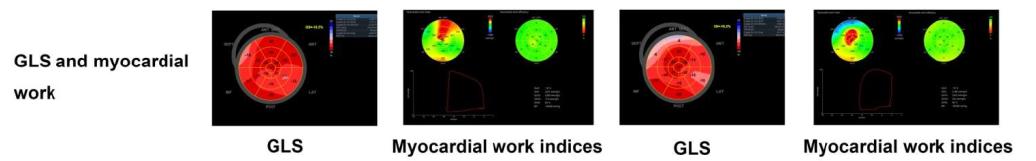
Figure 4. Main echocardiographic findings in primary hypertension and primary aldosteronism. Two representative cases of different echocardiographic parameters in a patient with primary hypertension ( left panels ) and in another with primary aldosteronism ( right panels ) with similar blood pressure. CS—circumferential strain; GLS—global longitudinal strain; LS—longitudinal strain. Values in the figure are expressed as below. Blood pressure: 149/69 in the primary hypertensive patient vs. 150/83 mmHg in the primary aldosteronism patient; left ventricular mass index: 97 vs. 145 g/m 2 , respectively; E/A: 1.4 vs. 0.88, respectively; E/e’: 10.4 vs. 18.9, respectively; CSendo (basal short- axis view): − 42.8 vs. − 39.2%, respectively; CSmid: − 26.3 vs. − 21.5%, respectively; CSepi: − 13.6 vs. − 10.4%, respectively; LSendo (four-chamber view): − 21.4 vs. − 19.9%, respectively; LSmid: − 19.0 vs. − 16.4%, respectively; LSepi: − 16.8 vs. − 13.3%, respectively; LASs (left atrial strain, four- chamber view): 27.8 vs. 20.4%, respectively; LASe: 17.6 vs. 10.7%, respectively; LASa: 10.3 vs. 9.8%, respectively; right ventricular four-chamber longitudinal strain: − 24.6 vs. − 17.3%, respectively; GLS: − 18.5 vs. − 16.2%, respectively; global myocardial work index: 2201 vs. 2196 mmHg%, respectively; global constructive work: 2336 mmHg% vs. 2322 mmHg%, respectively; global wasted work: 174 vs. 234 mmHg%, respectively; global work efficiency: 93 vs. 90%,